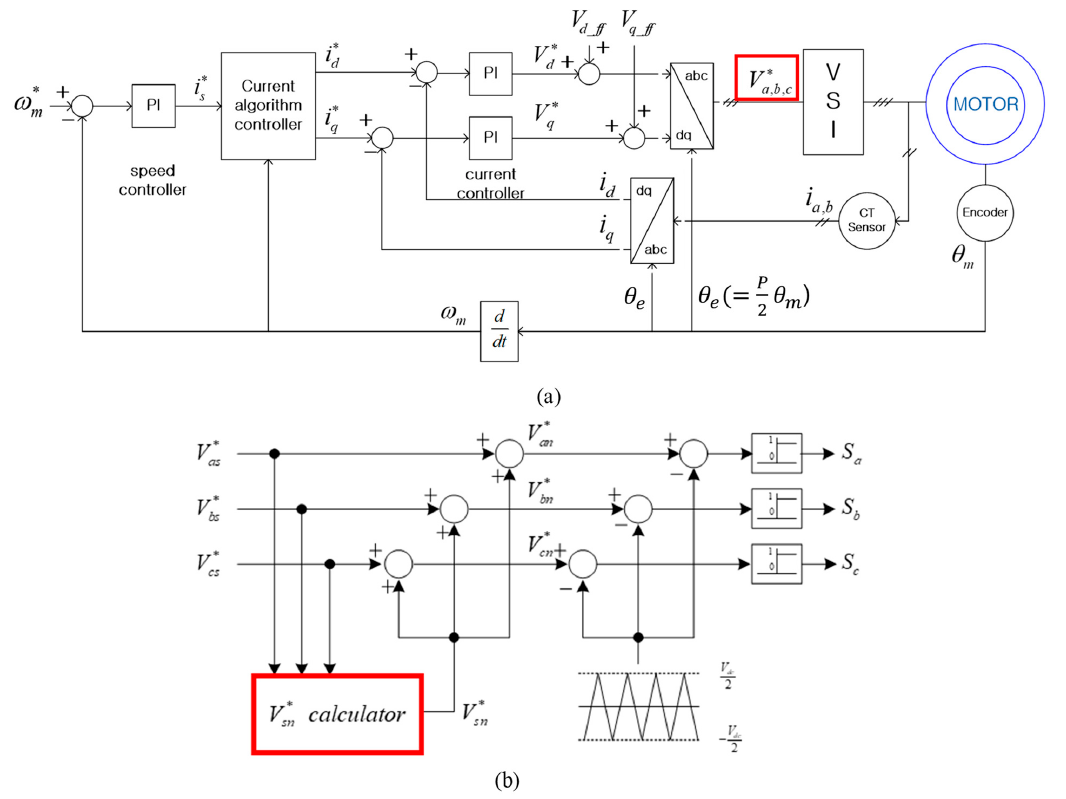
Figure 5. Control block for IPMSM speed control: ( a ) IPMSM control algorithm; ( b ) switching function for injecting the offset voltage.